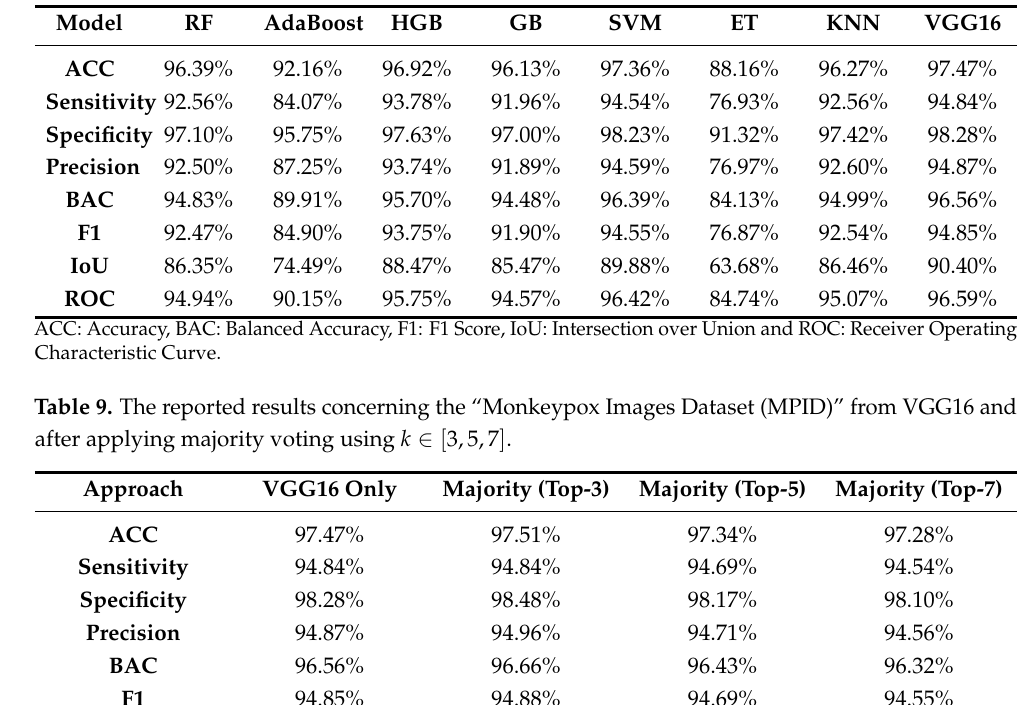
Table 8. The reported results concerning the “Monkeypox Images Dataset (MPID)” after optimizing three machine learning classifiers on the extracted and processed features beside the results of the VGG16 model.